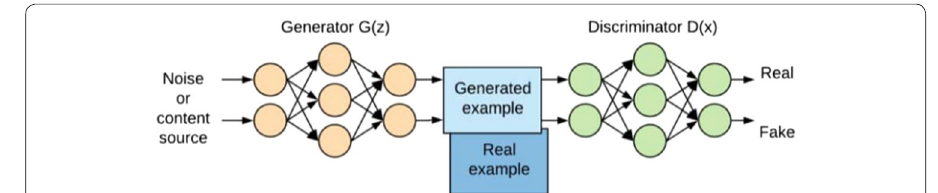
Fig. 16 Illustration of GAN concept provided by Mikolajczyk and Grochowski